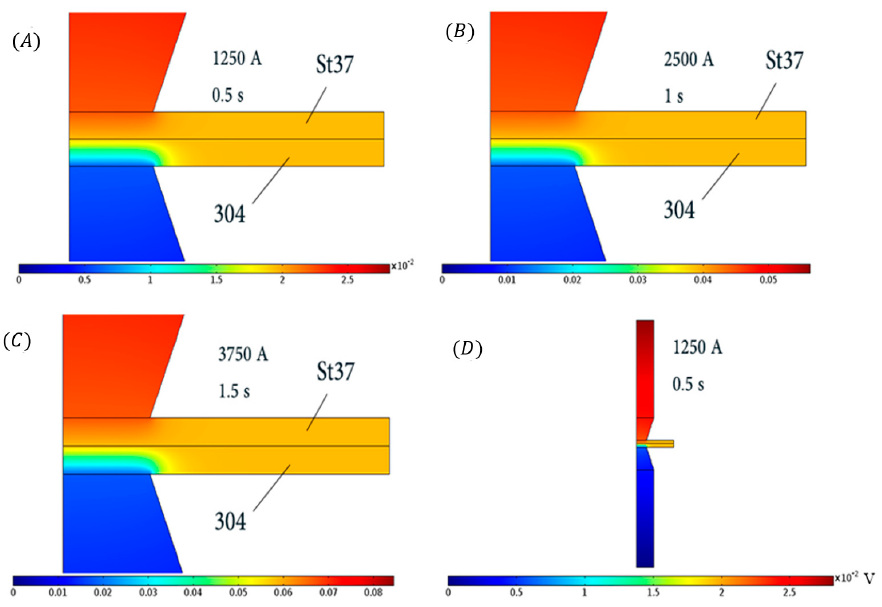
Figure 3. Simulation results of electrical potential distribution in the weld zone, ( a ) 1250 A and 0.5 s, ( b ) 2500 A and 1 s, ( c ) 3750 and 1.5 s, ( d ) electrodes 1250 A and 0.5 s .